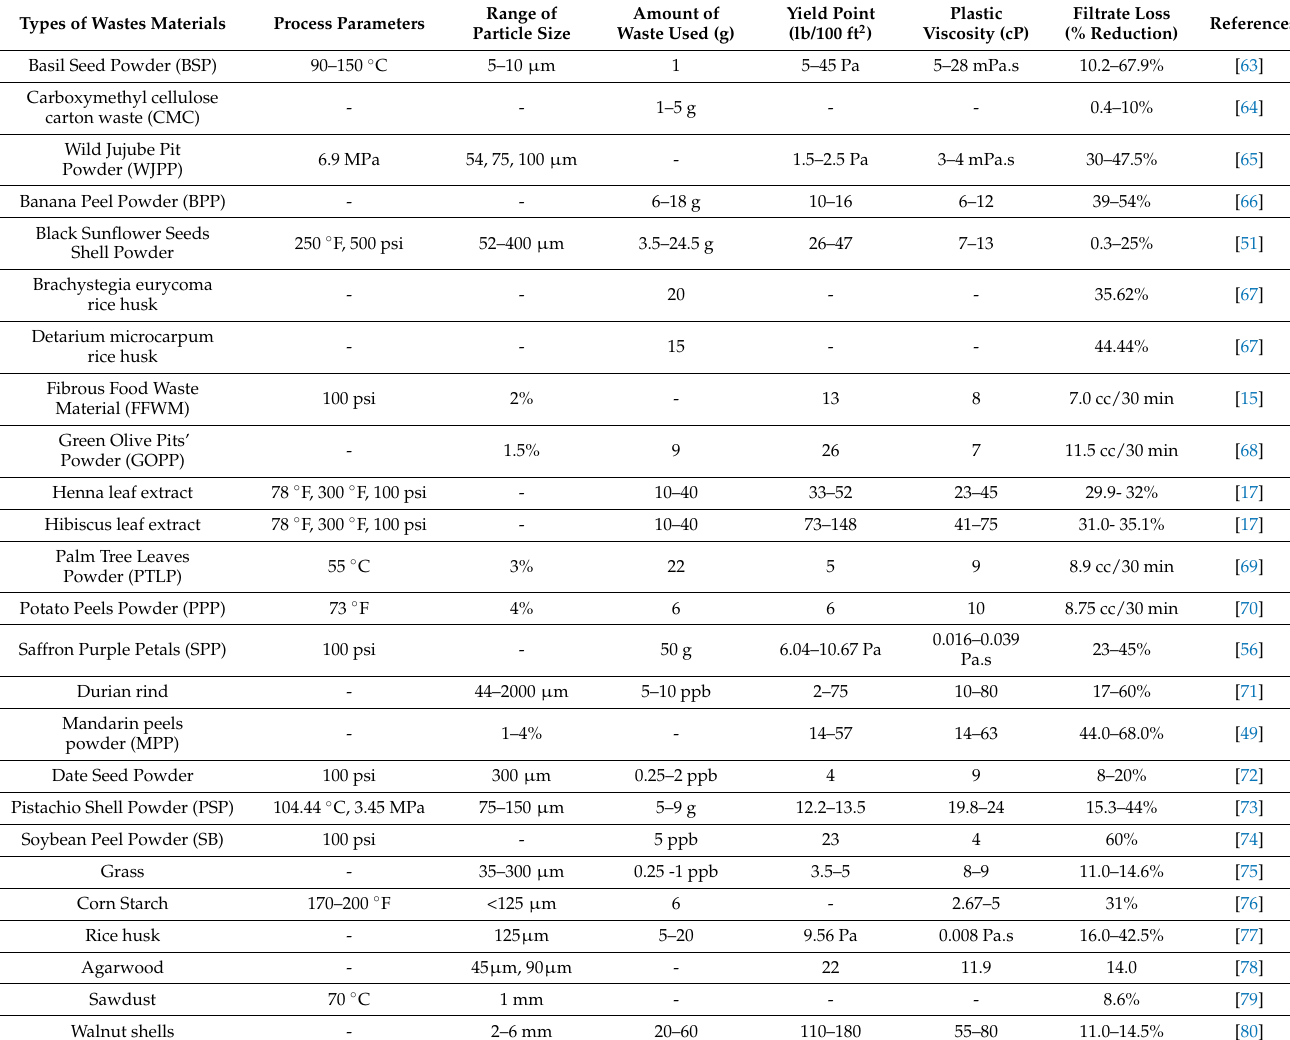
Table 1. Summary of rheological properties of waste-derived materials in drilling